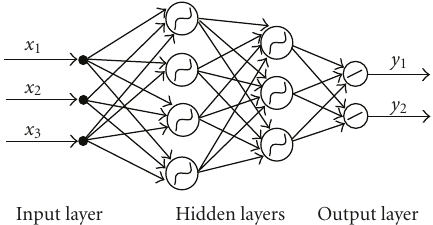
Figure 9: A multilayer neural network: this network has 3 layers, 3 input signals, 4 neurons in the first layer, 3 neurons in the second layer, and 2 neurons in the output layer (2 output signals).